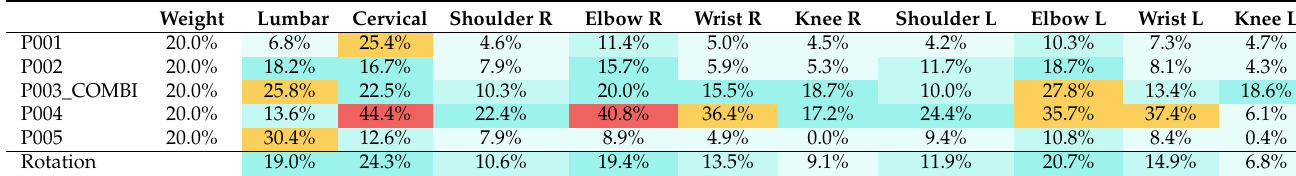
Table 12. Example of a risk map and job rotation, considering a specific weight assigned to each situation (for combinations) or each workstation (for job